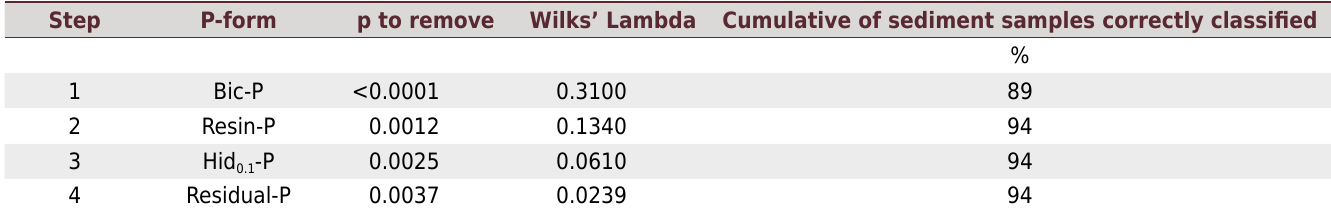
Resin-P: available P extracted by anion exchange resin membrane. Bic-P: P extracted by 0.5 mol L ‒1 NaHCO 3 at pH 8.5. Hid 0.1 -P: P extracted by 0.1 mol L ‒1 NaOH. Residal-P: P residual obtained after digestion with H 2 SO 4 and H 2 O 2